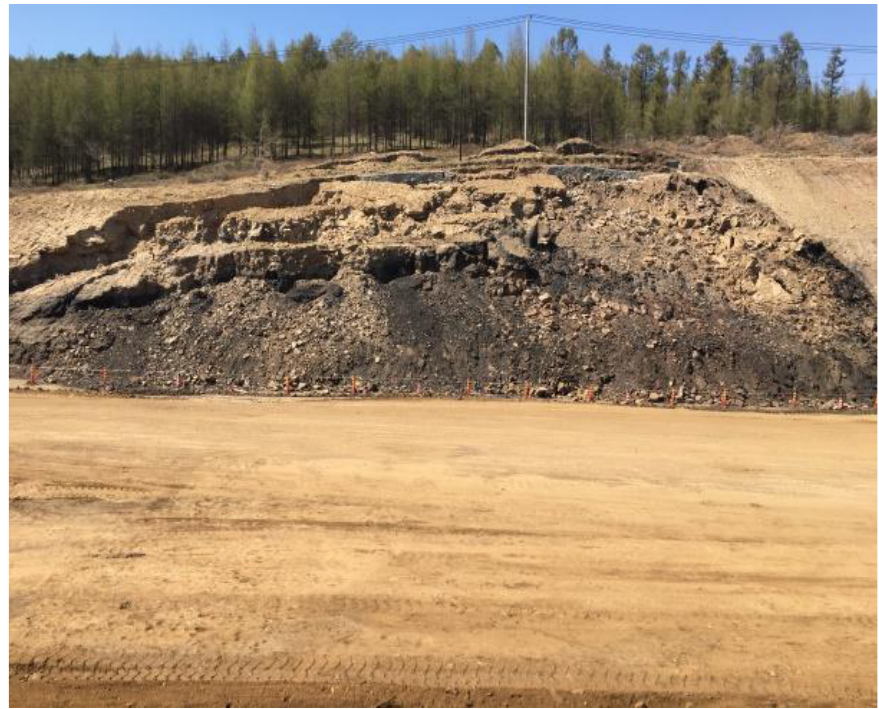
Figure 7. Side view of the instability and collapse of a slope containing a coal seam in a goaf.